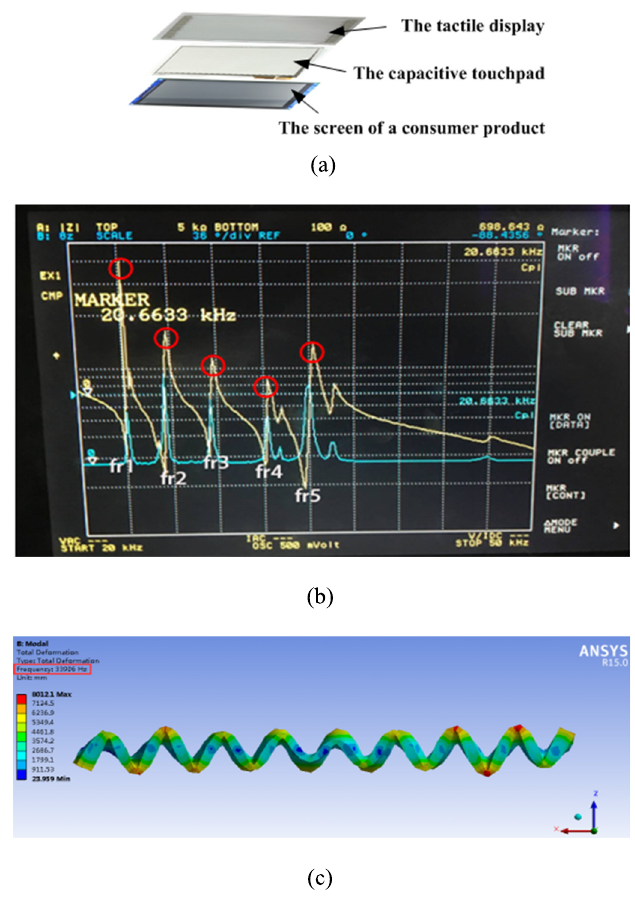
Fig. 3. Design and characteristics of texture-rendering plate. (a) Layout of the plate. (b) Impedance diagram of typical piezoelectric ceramic. fr1, fr2, fr3, fr4, and fr5 are equal to 22.95, 25.31, 28.32, 32.06, and 34.71 KHz, respectively. The ceramic resonates at these frequencies as marked in red circles. (c) Modal analysis of glass plate and piezoelectric ceramics together to show standing wave.